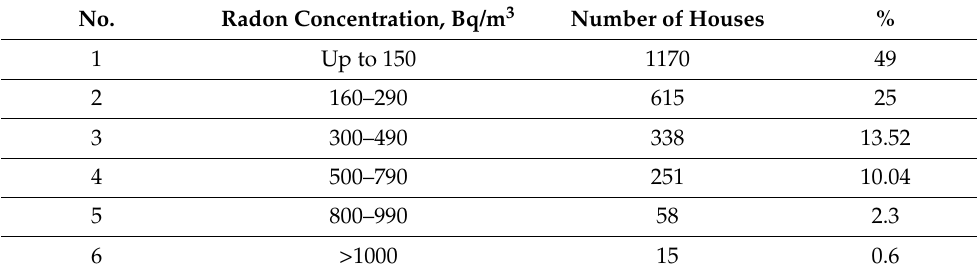
Table 2. Results of the radon concentration measurement with RADTRAK2 detectors (passive measurement, exposure period 90 days) in 2447 dwellings in rural and urban areas of the Republic of Moldova, in